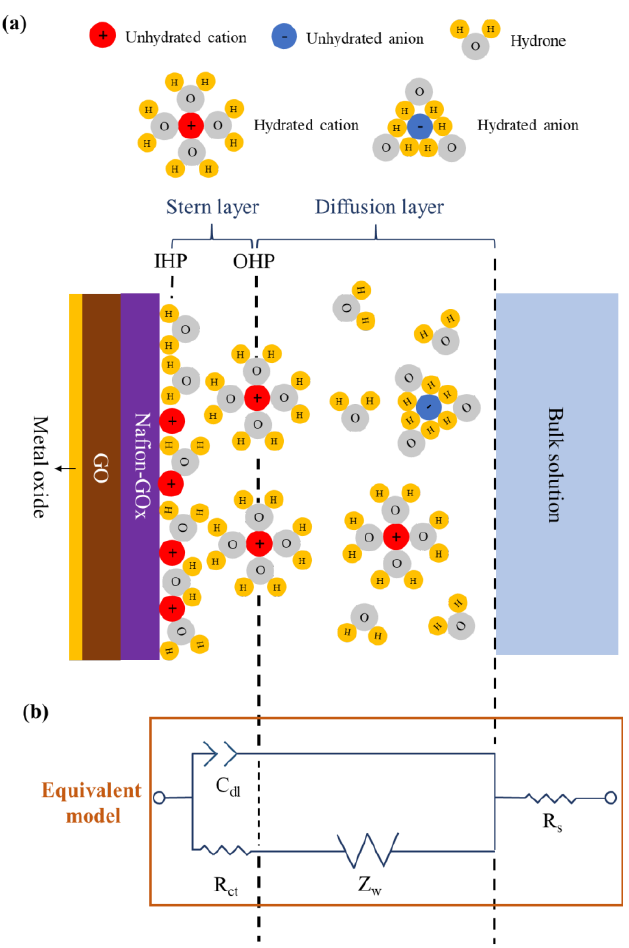
Figure 8. ( a ) Schematic diagram of the membrane – solution interface. ( b ) Equivalent circuit model for electrochemical impedance spectroscopy (EIS). Sensors 2020 , 20 , x FOR PEER REVIEW